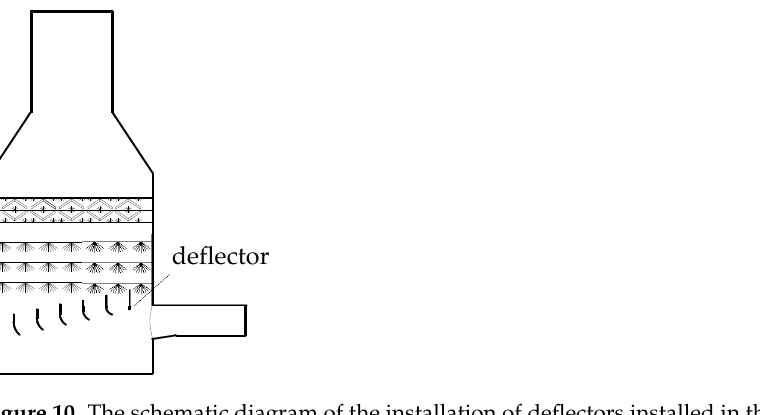
Table 2. Drop of pressure between inlet and outlet.